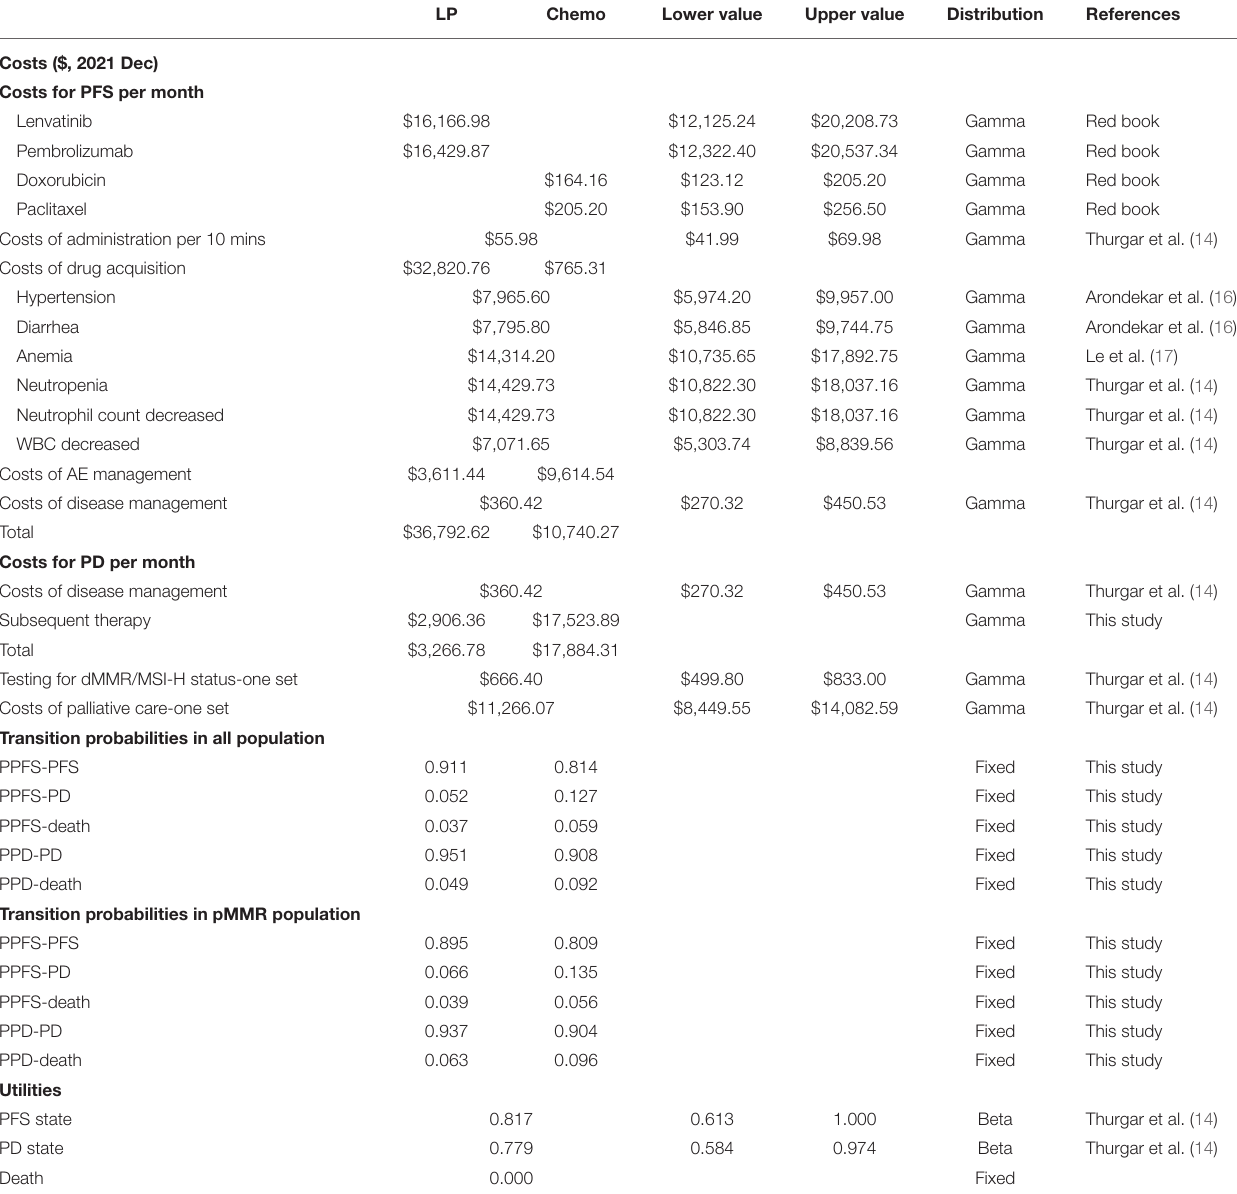
TABLE 2 | Input parameters and